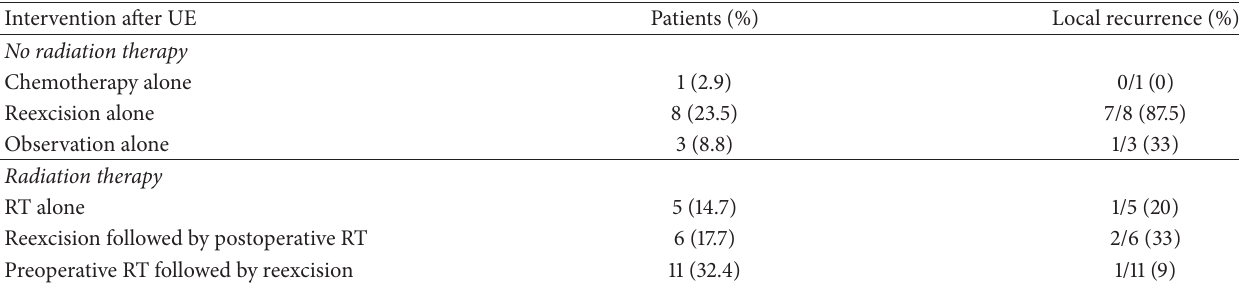
Table 2: Post-unplanned excision therapies.